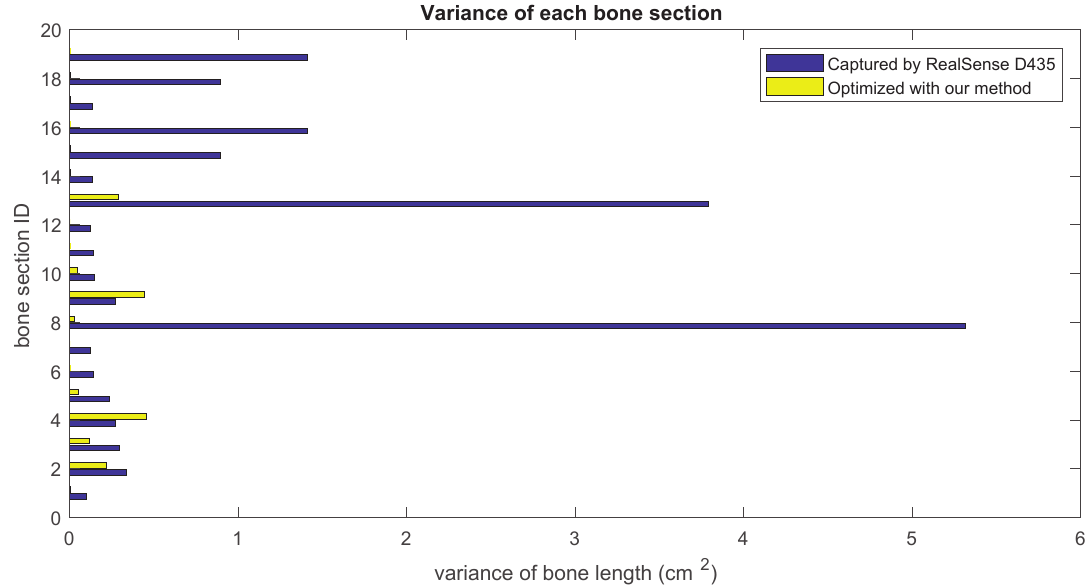
Figure 11. The summation of the bone length variance for each bone section over all frames. Purple: variance of the bone length captured with Kinect SDK [1]. Yellow: variance of the optimized bone length after applying our method.